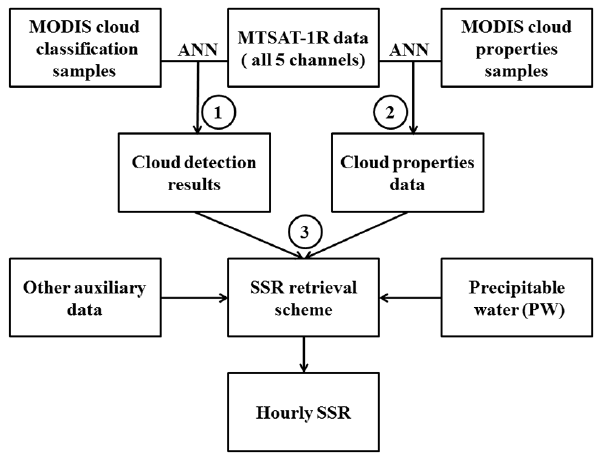
Figure 2. Flowchart of the SSR retrieval